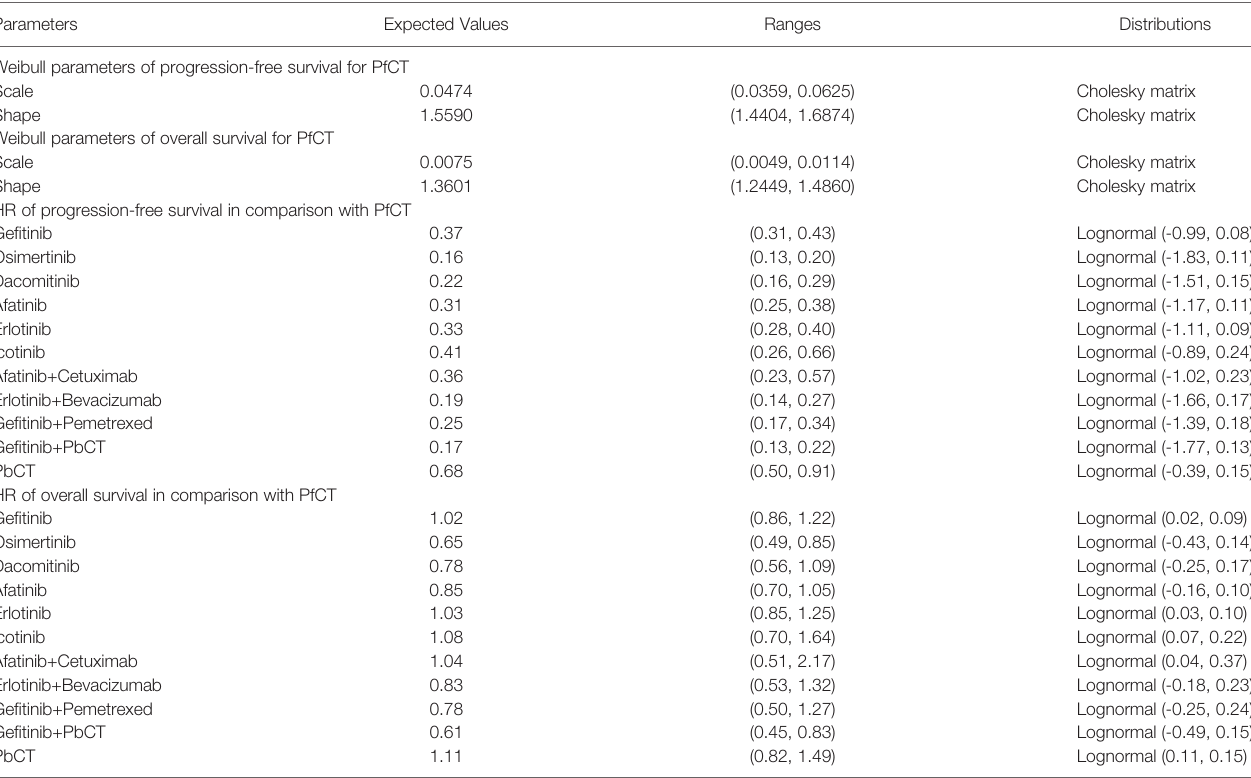
TABLE 1 | Key clinical inputs. Parameters Expected Values Ranges